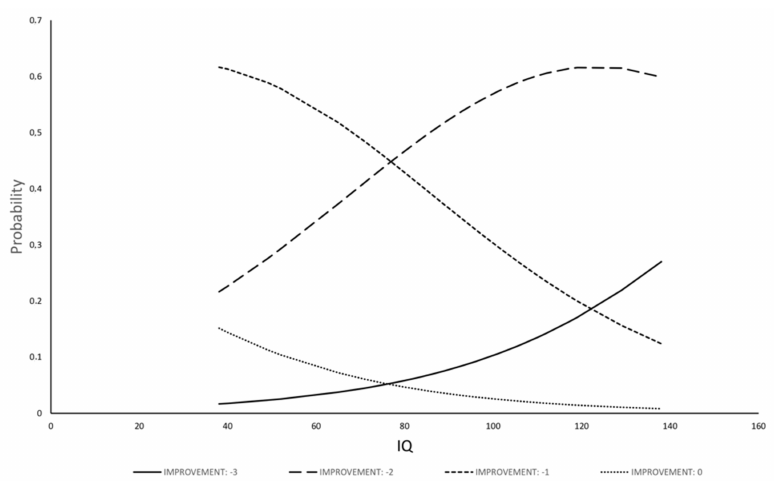
Figure 1. Relationship between probability to have a certain class of ∆ CGI-S amelioration and IQ in ASD + ADHD